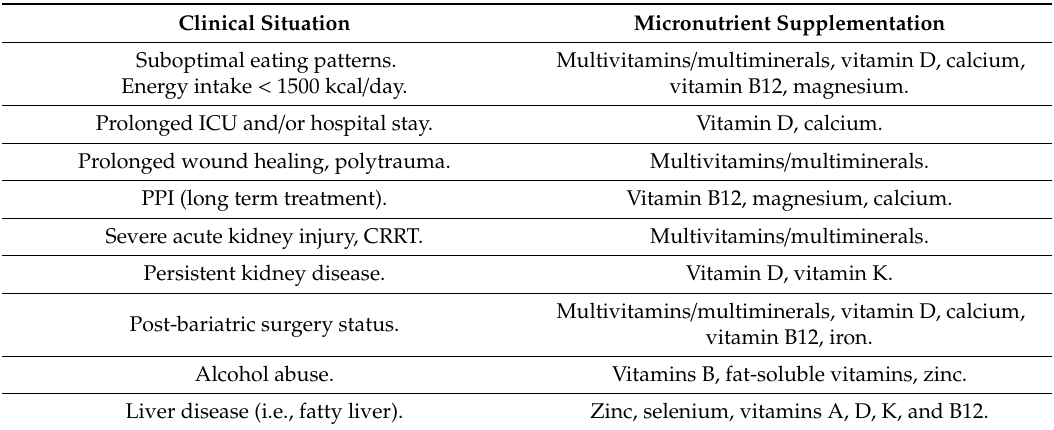
Table 3. Frequent clinical situations at risk of micronutrient deficiency and the corresponding suggested supplementation during ICU stay or in ICU survivors (adapted from [62,69]). Clinical Situation Micronutrient Supplementation Suboptimal eating